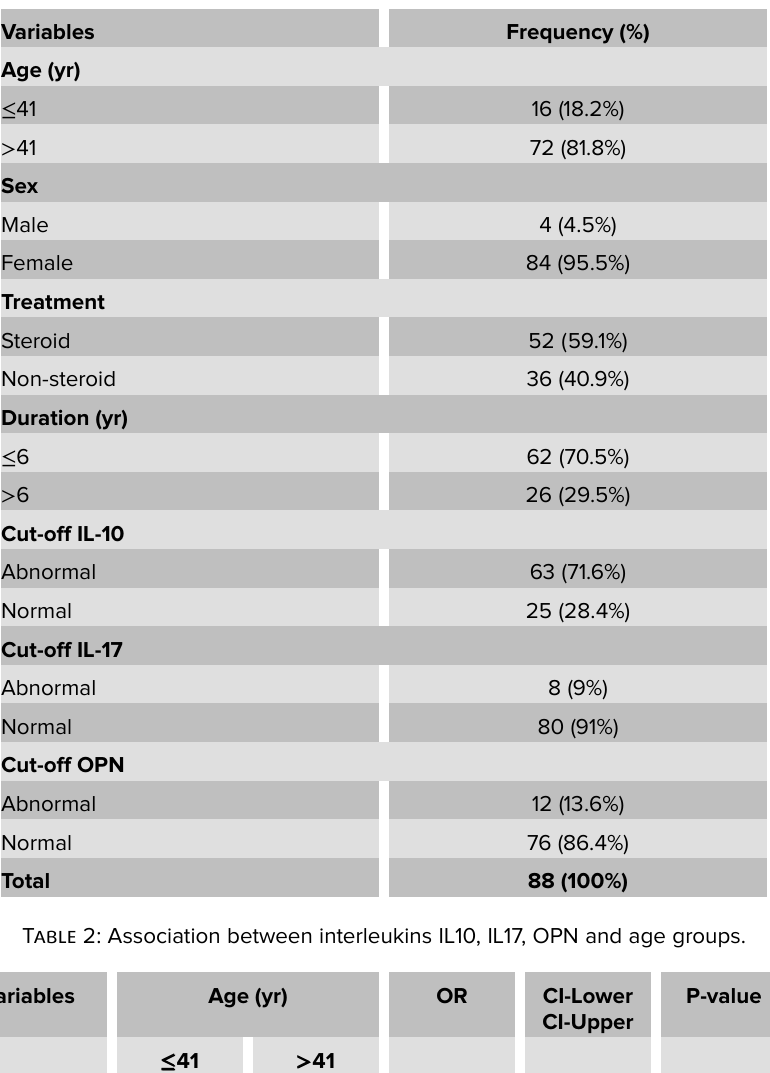
TABLE 1: Demographic and baseline characteristics of RA Patients.